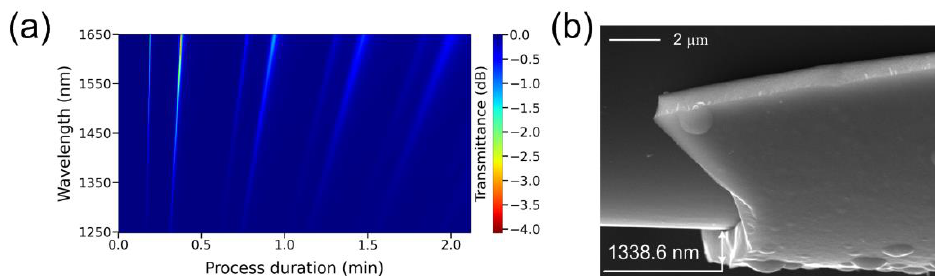
Figure 9. ( a ) Spectral response as a function of process duration for a thinned optical fiber with a ZnTe coating in the wavelength range of 1250 – 1650 nm. ( b ) SEM image of the destroyed layer.